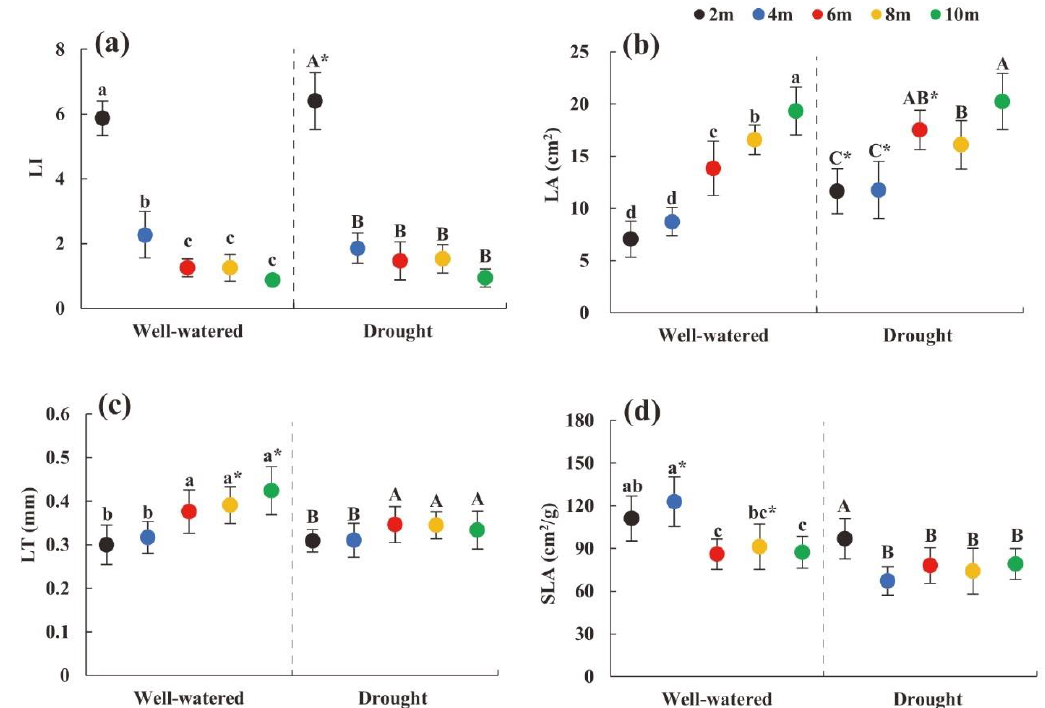
Figure 1. Changes in morphological characteristics of heteromorphic leaves with different tree heights under different soil moisture conditions. Note: ( a – d ) were changes in leaf index, leaf area, leaf thickness, specific leaf area with different tree heights under different soil moisture conditions. The black dot indicates the height of the 2 m tree, the blue dot indicates the height of the 4 m tree, the red dot indicates the height of the 6 m tree, the yellow dot indicates the height of the tree 8 m, and the green dot indicates the height of the 10 m tree; lowercase and uppercase letters represent the significance of the difference between different sampling heights under suitable soil moisture conditions and soil drought stress conditions, and * represents the comparison of the same height under different habitats ( p < 0.05). LI: leaf index; LA: leaf area; LT: leaf thickness; SLA: specific leaf area.